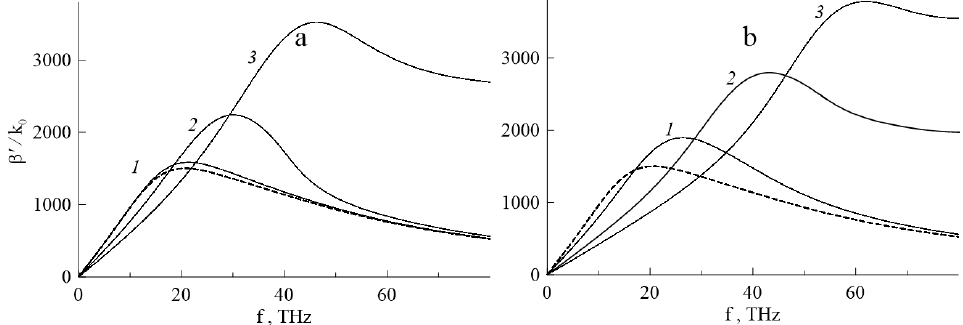
Figure 4. Frequency dependence of the real part of the propagation constant in a structure with doped and inverted graphenes ( a , b ); ε 2 = 10, µ = 0;0.02;0.06;0.10 eV (dashed curve and curves